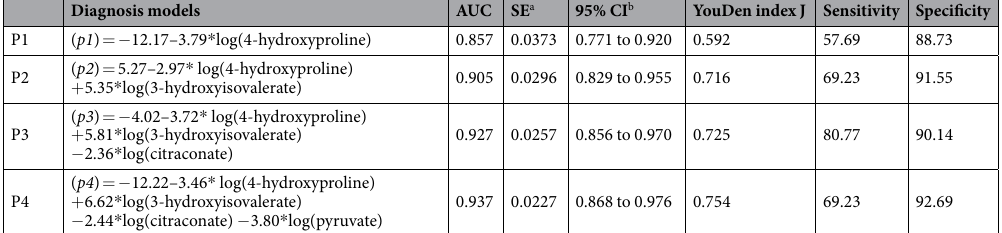
Table 2. Diagnostic models from the logistic regression and the ROC analysis results. a Standard Error; b Confidence